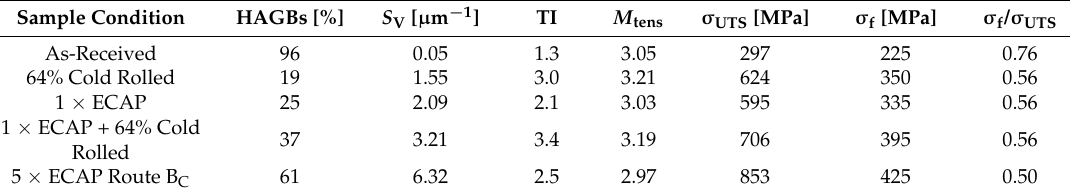
Table 1. Fraction of high angle grain boundaries (HAGBs), total boundary density ( S V ), texture index (TI), average Taylor factor along the tensile axis ( M tens ), ultimate tensile strength ( σ UTS ), endurance limit based on 10 7 cycles ( σ f ), and fatigue ratio ( σ f / σ UTS ) for ARMCO ® iron in different processing conditions